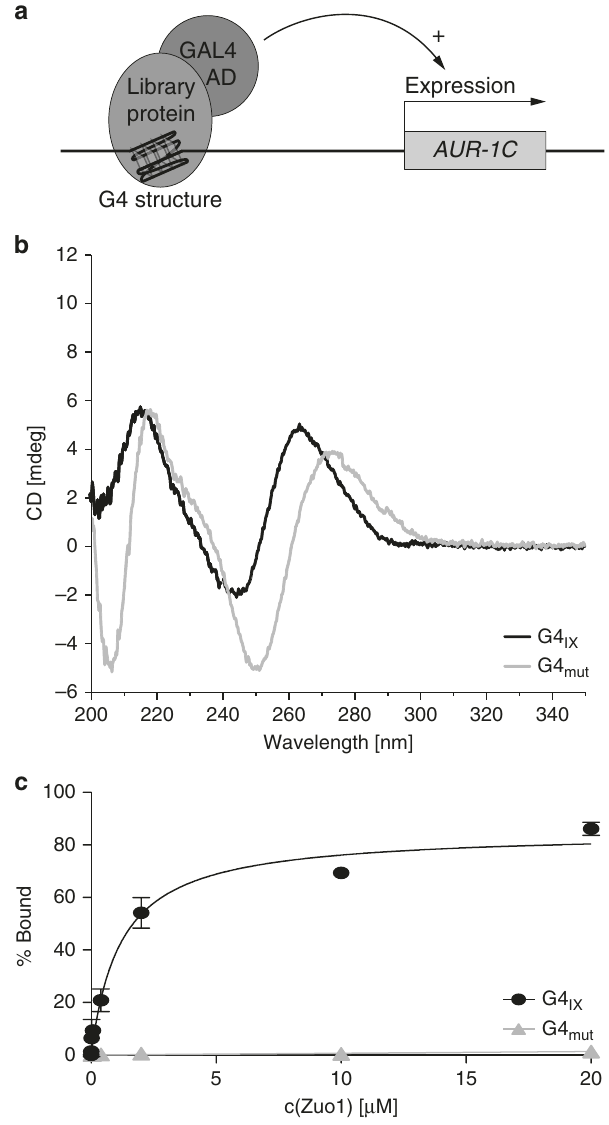
Fig. 1 Zuo1 binds to G-quadruplex structures in vitro. a Graphic illustration of the yeast one-hybrid screen (Y1H) system. GAL4 AD, Galactose Activation Domain. AUR-1C , Aureobasidin A b CD spectra of the folded oligonucleotides G4 IX and G4 mut in the presence of 100 mM K + . c Quanti fi cation of Zuo1-binding to G4 IX and G4 mut by fi lter binding assay. Error bars correspond to one standard deviation of the mean of three independent